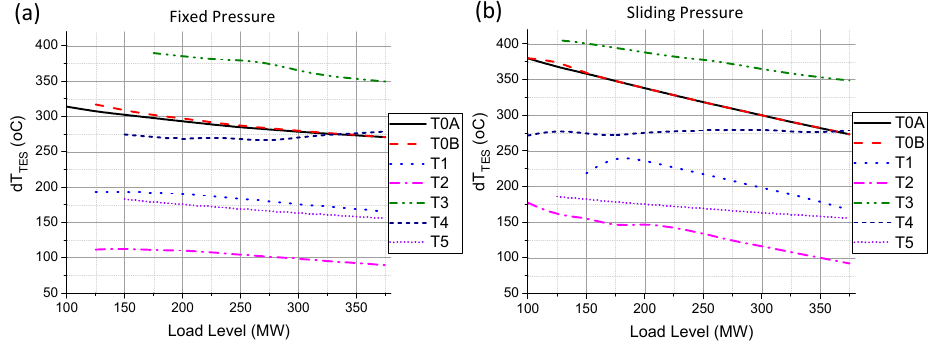
Figure 13. TES inlet temperature in FP ( a ) and SP ( b ) operating mode.